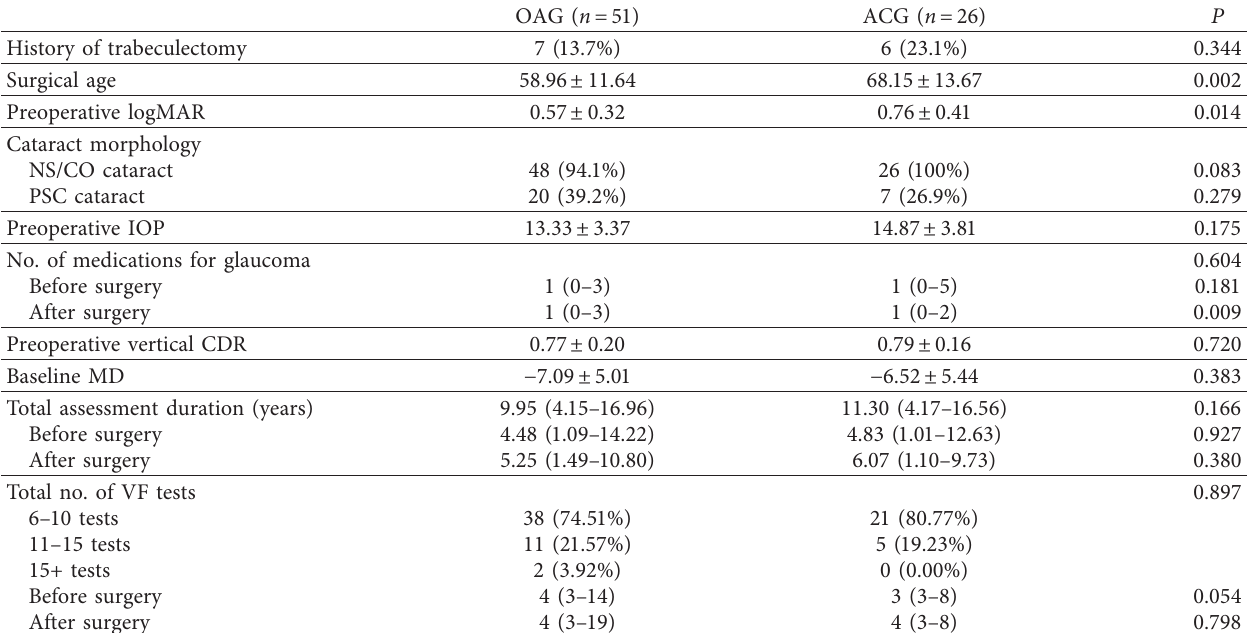
Table 1: Demographics and clinical characteristics among 77 eyes with open-angle and angle-closure glaucoma.